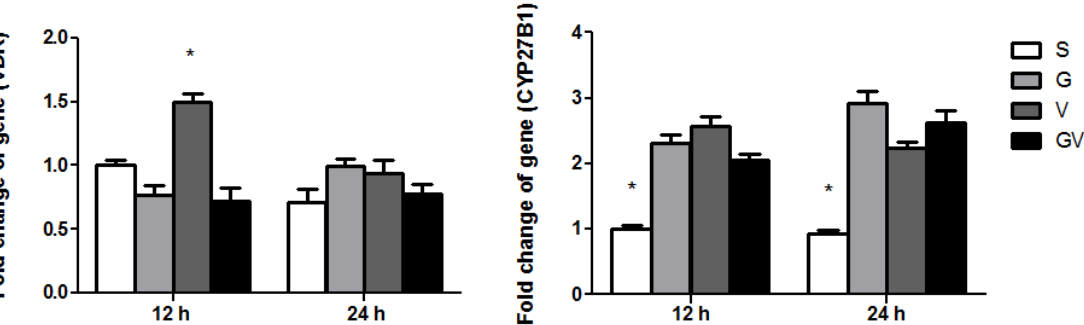
Figure 4. Messenger (m)RNA expression levels of the vitamin D receptor (VDR) and cytochrome p450 27B1 (CYP27B1) genes in ileum tissues after cecal ligation and puncture at two time points. mRNA changes were quantitated and analyzed by real-time PCR and were calculated using the comparative CT (2 −ΔΔCt ) method. mRNA expression levels in the S group were used as a calibrator. Data are presented as the mean ± standard error of the mean (SEM). n = 8 for each group. The groups are described in the legend of Figure 1. Differences among groups at the same time point were analyzed by a one-way analysis of variance using Tukey’s post hoc test. * Significantly differs from the other groups at the same time point ( p < 0.05).